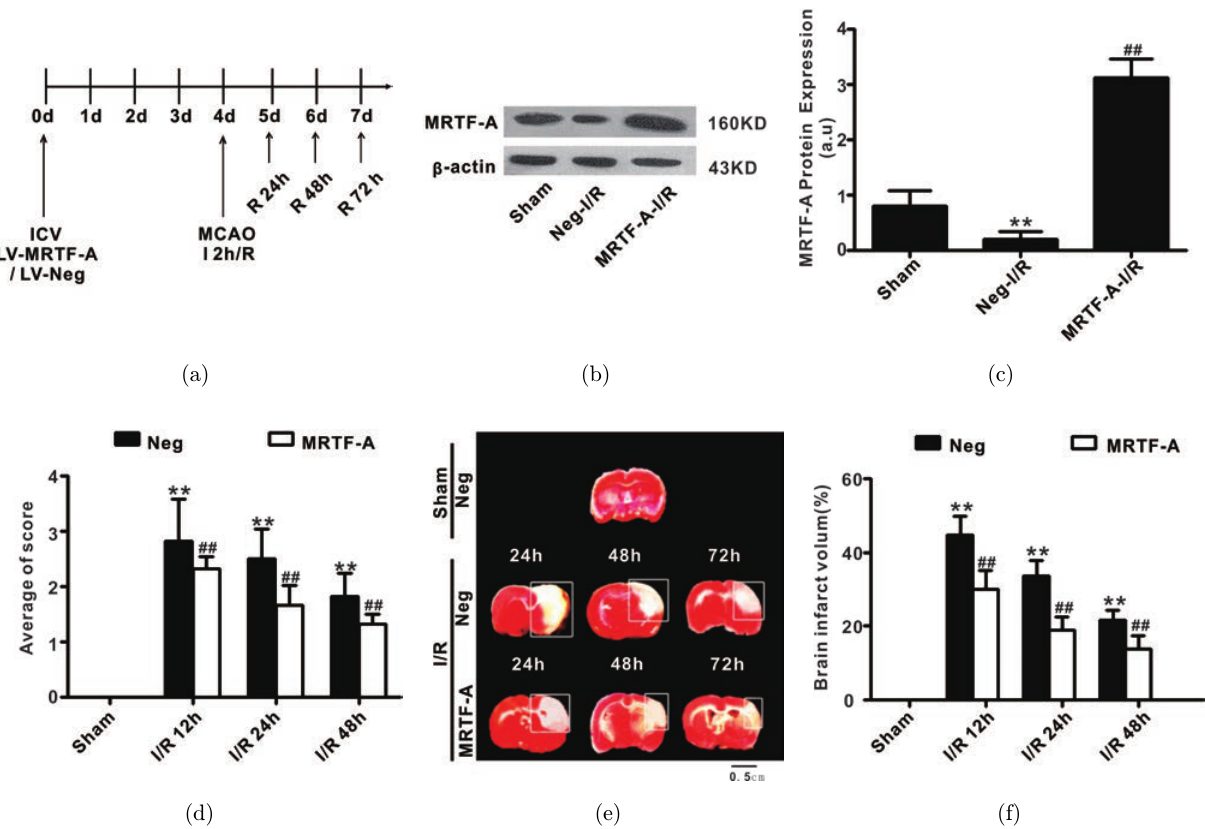
Fig. 1. MRTF-A overexpression improved neurological function in rats with MCAO/R-induced brain injury. (a) Schematic representation of the experimental design. (b) and (c) After the exogenous injection of lentivirus packaging MRTF-A plasmids, MRTF-A expression in MCAO 2 h/R 24 h was assessed via western blot analysis. (d) The Longa score scale was used to evaluate neurological de¯cits 24, 48, and 72 h after cerebral ischemic/reperfusion (I/R) injury. (e) Representative samples of 2, 3, 5- triphenyltetrazolium chloride-stained brain slices 24, 48, and 72 h after I/R injury. (f) The statistical analysis of the percentage of infarct volume 24, 48, and 72 h after I/R injury. * P < 0 : 05, ** P < 0 : 01 versus the sham group, # P < 0 : 05, ## P < 0 : 01 versus the Neg-I/R group. Data were presented as mean (cid:1) SD , n ¼